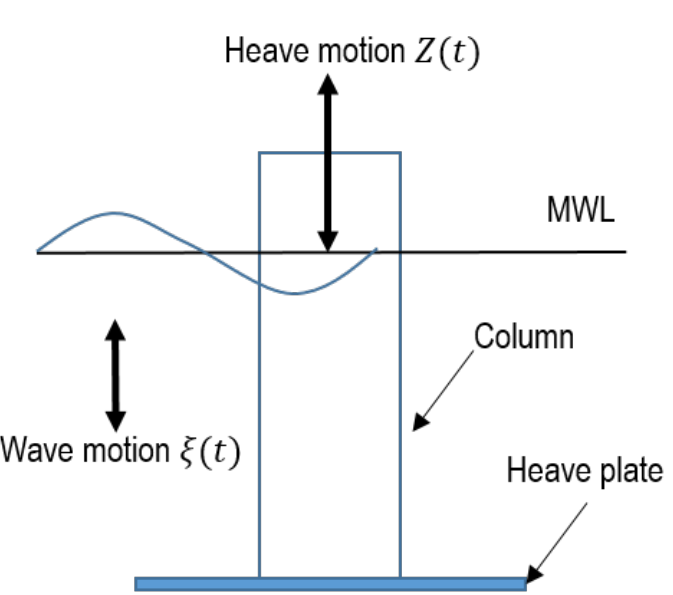
Figure 2. Schematic of a column with heave plate showing motions of